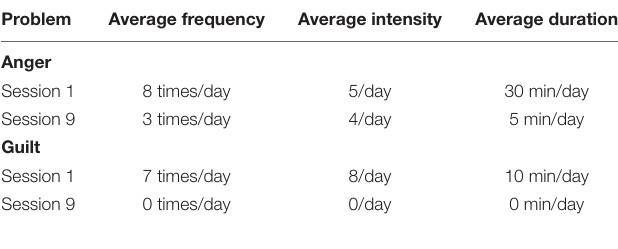
TABLE 2 | Functional behavior analysis of anger and guilt.